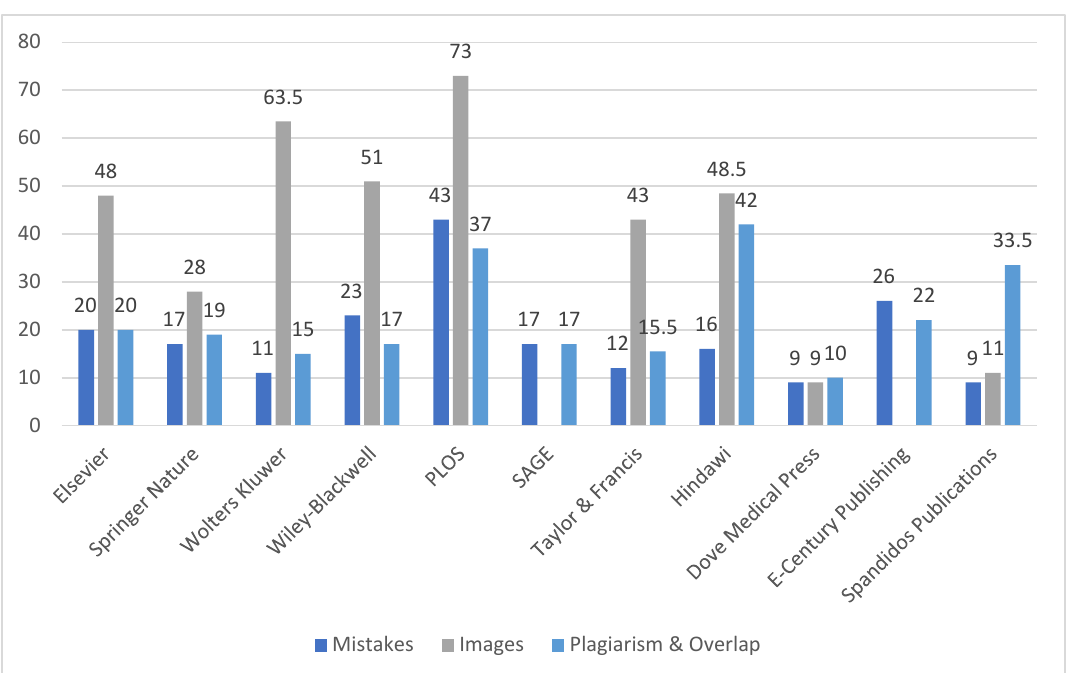
The median values of ET are between 10 months (Dove Medical Press) and 42 months (Hindawi) with major publishers relatively well-positioned: 15 months for Wolters Kluwer, 15.5 months for Taylor & Francis, 17 months for Wiley-Blackwell and SAGE, 19 months for Springer Nature, and 20 months for Elsevier. Average values of ET spread between 17.5 months (Dove Medical Press) and 40.1 months (Hindawi). Median values for the top three retraction reasons are represented in Figure 1.